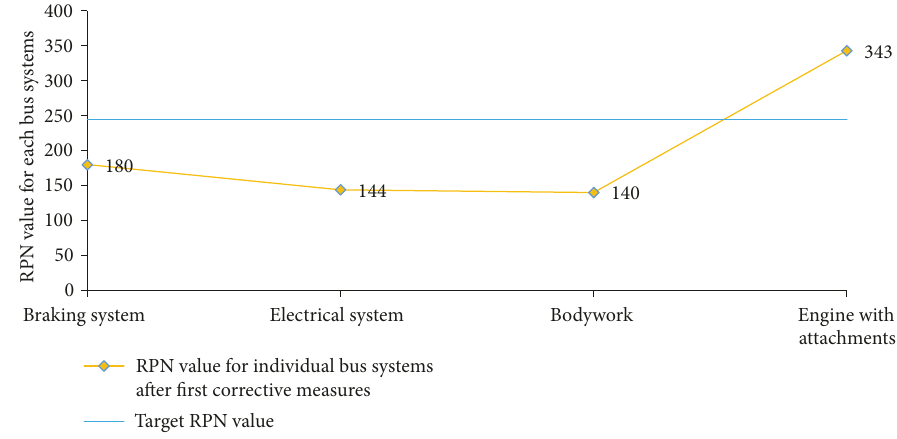
Figure 8: RPN value for each of the bus systems after the first phase of corrective action based on FMEA.